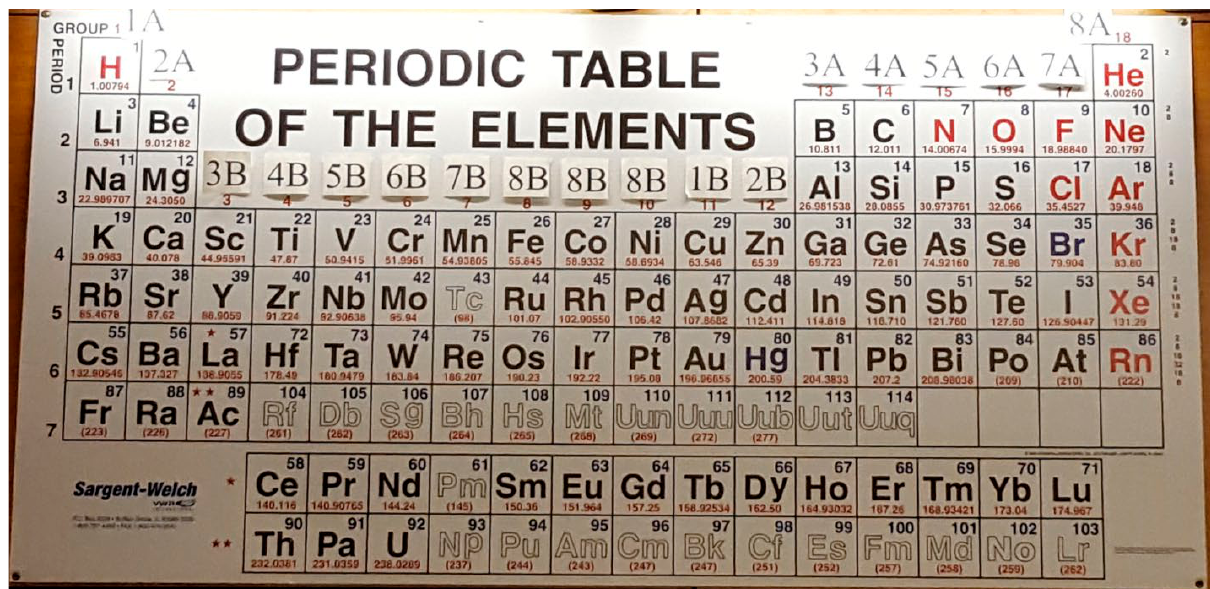
Figure 10. A periodic table wallchart (Sargent-Welch) on which the A/B group numbers have been taped above the 1-18 group numbers (Photo taken by the author at the University of Massachusetts Amherst, June